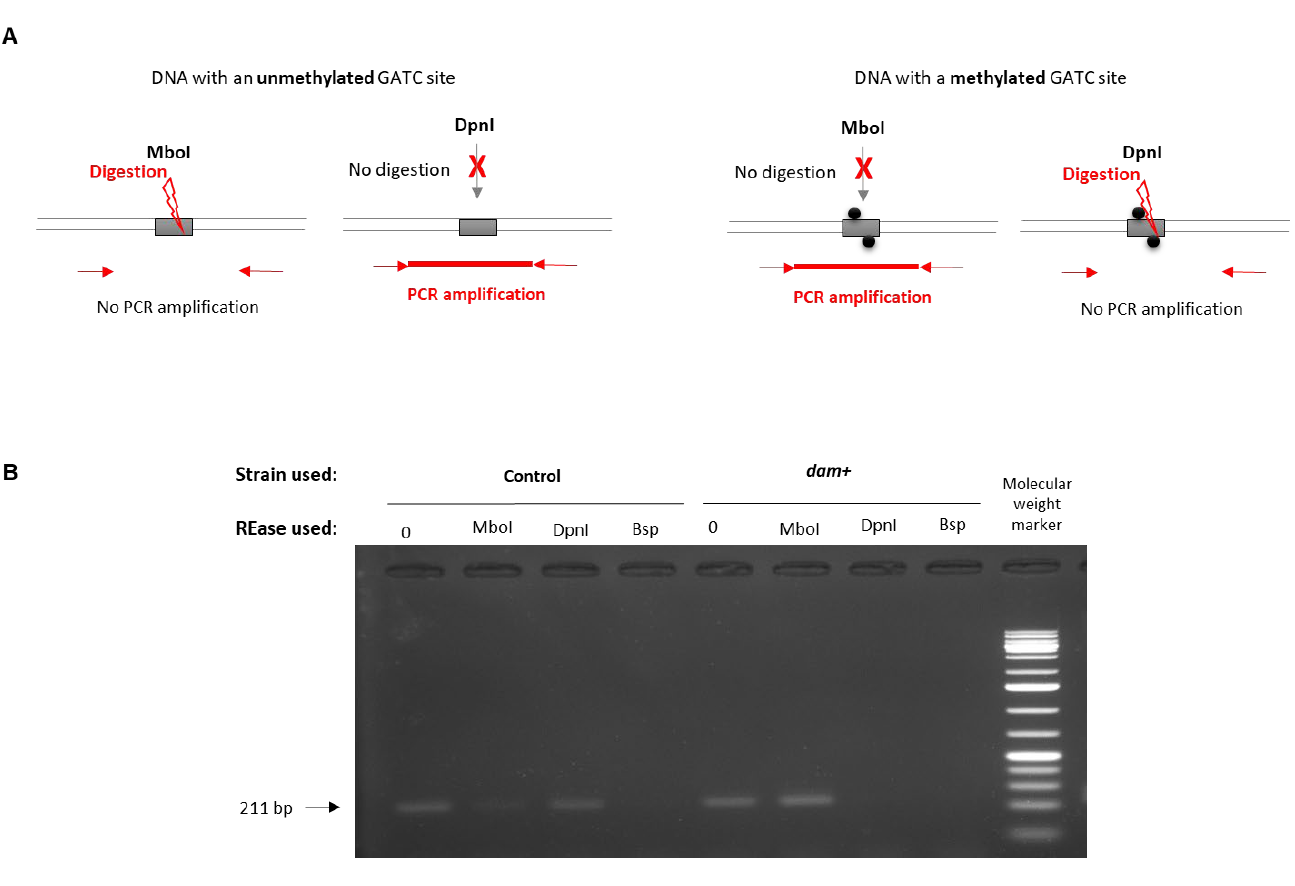
Figure 5. Methylation-sensitive restriction enzyme (MSRE)-PCR analysis. ( A ) Theoretical repre- sentation of a DNA region with a methylated (grey box with black circles) or unmethylated (grey box) GATC site, treated by MboI or DpnI restriction enzymes, and followed by PCR amplification (for which primers are represented by red arrows). ( B ) PCR amplification of a X. nematophila F1 locus (in the vicinity of XNC3v3_2082) harboring two unmethylated GATC sites was performed using DNA extracted from X. nematophila overexpressing dam strain ( dam+) or from the control strain (carrying the pBBR1-MCS5 empty vector) after incubation with various restriction endonu- cleases: MboI (digests unmethylated GATC), DpnI (digests methylated GATC), or Bsp143I (digests GATC sites, whatever the methylation state). A positive-control PCR with undigested DNA (la- belled as “0”) was performed. A lack of detection of a 211 bp amplicon revealed that digestion occurred.